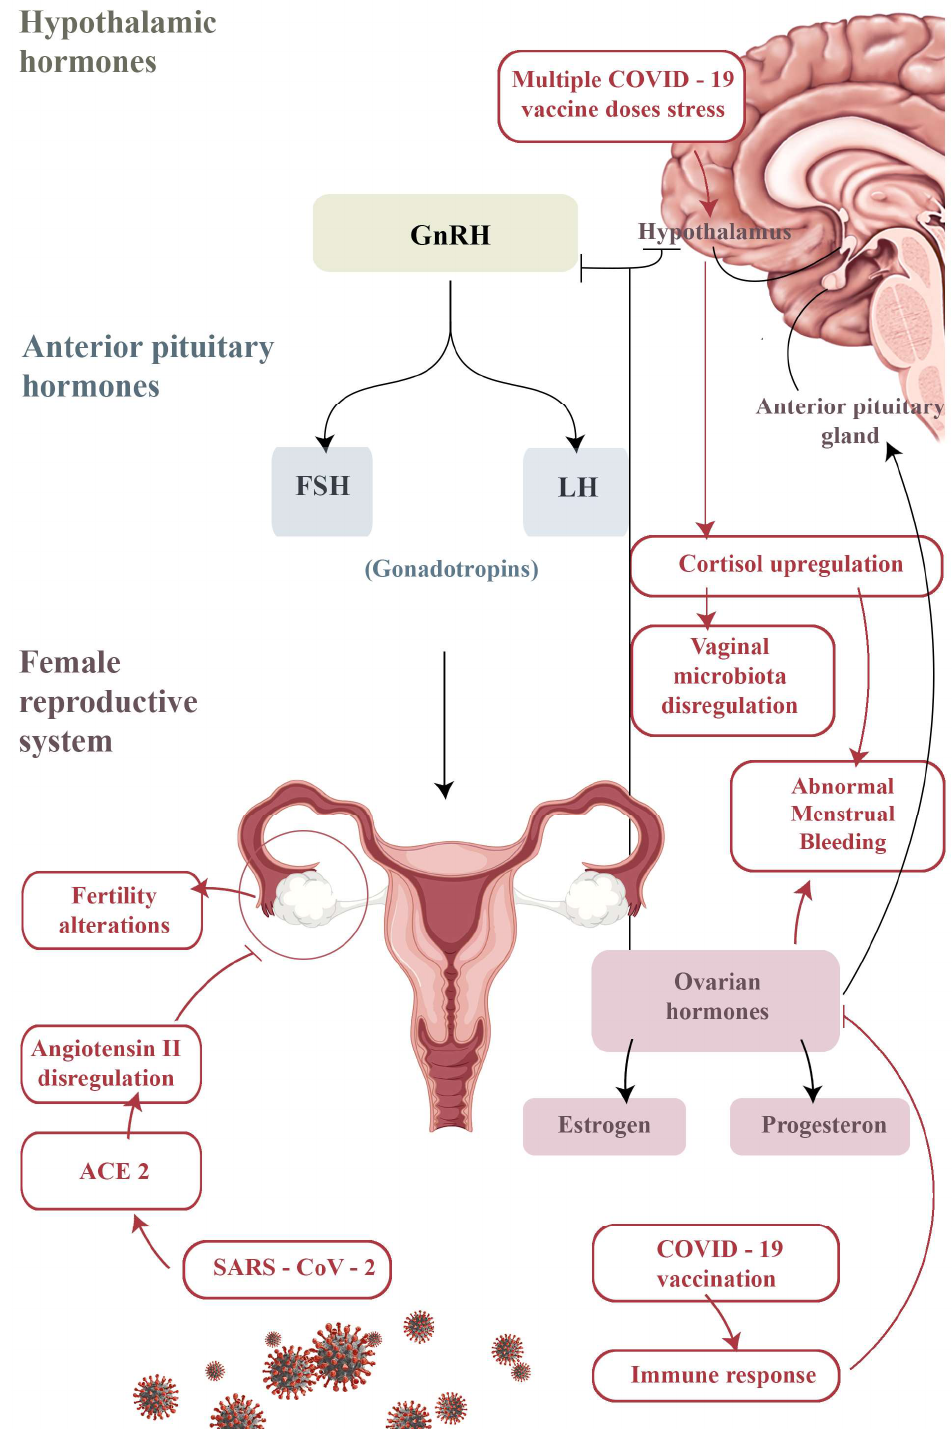
Figure 3. Schematic representation of the possible mechanisms underlying the neuroendocrine and gynecological adverse reactions to the SARS-CoV-2 vaccine. As in the case of the COVID-19 effect, acute stress induced by multiple vaccine doses could temporarily impair the hypothalamic–pituitary–gonadal axis by interfering with pulsatile GnRH secretion; otherwise, an upregulation of cortisol mediated by abnormal secretion of cortisol-releasing hormone (CRH) could lead to a dysregulation of the vaginal microbiota and ultimately to abnormal menstrual bleeding. An excessive immune response to the vaccine could also trigger a blockage of the aromatase enzyme, thus causing the same symptoms.